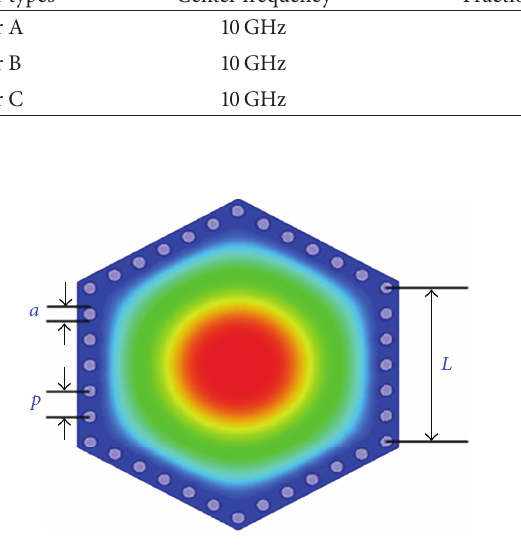
Figure 1: The configurations and electric field distributions of the fundamental mode of a hexagonal cavity resonator.